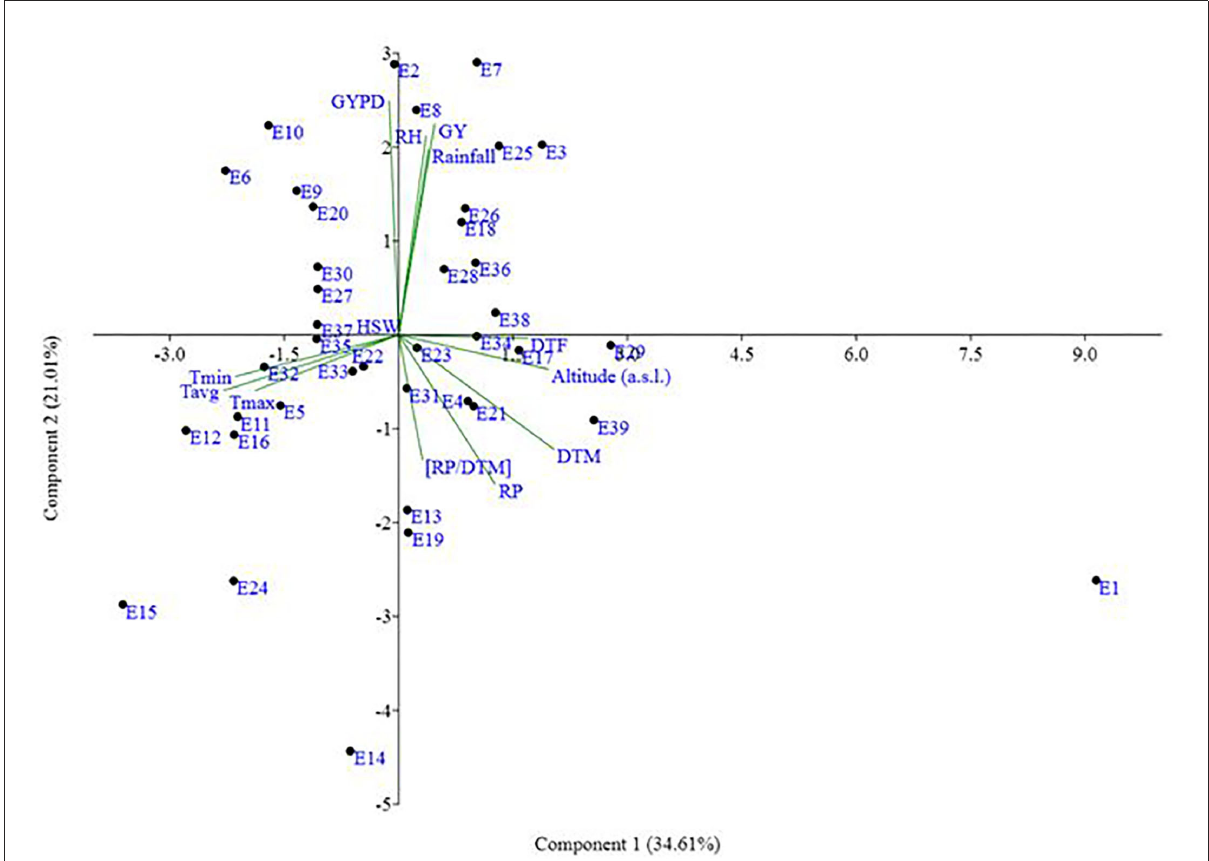
FIGURE6 Scatter plot environments on PCA coordinates and biplot presentation of crop phenology, seed weight, grain yield parameters, and weather variables. Please see Supplementary Table 1 for environment (E1–E39) detail.